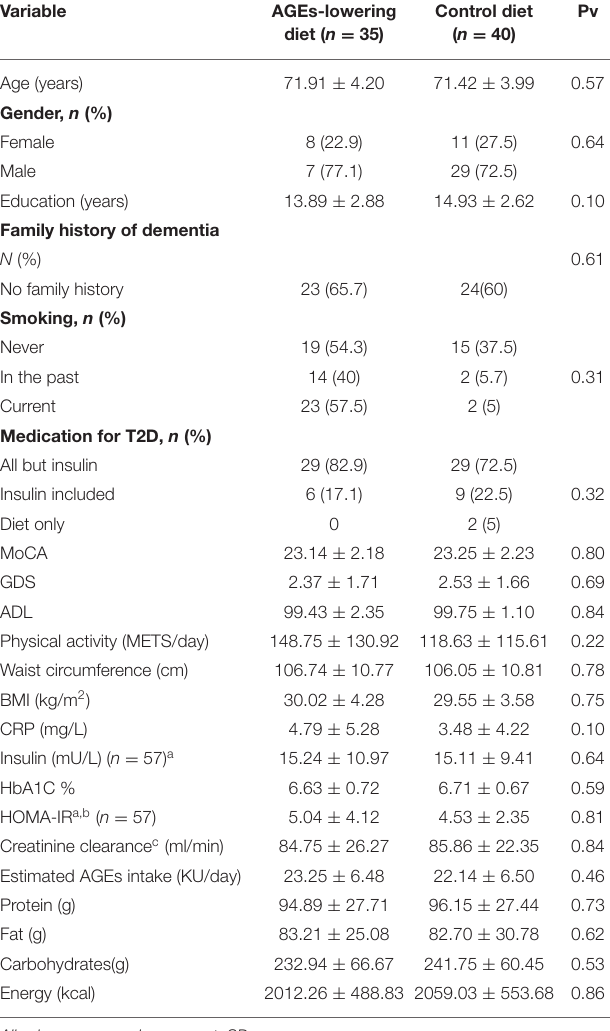
TABLE 3 | Baseline characteristics ( n =